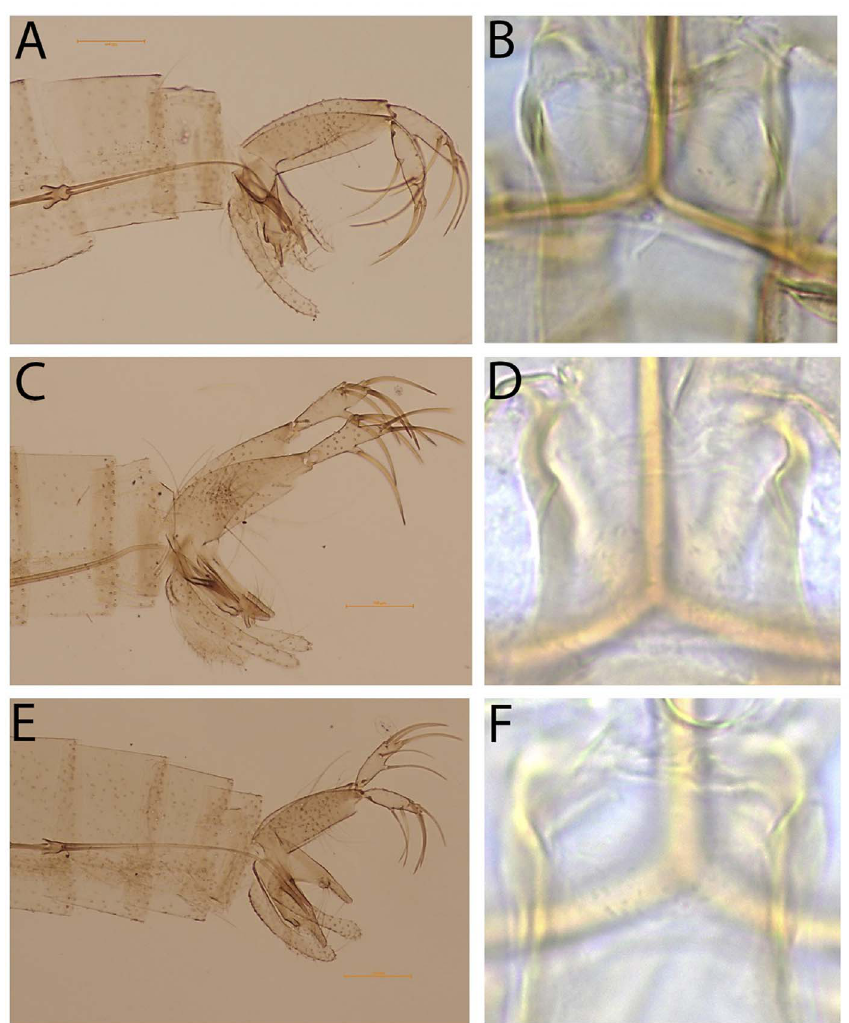
Figure 2. Classical characteristics of Phlebotomus mascomai , Ph. yunshengensis and Ph. betisi males. A and B: Genitalia and cibarium of Ph. mascomai male, respectively; C and D: Genitalia and cibarium of Ph. yunshengensis male, respectively; E and F: Genitalia and cibarium of Ph. betisi male, respectively